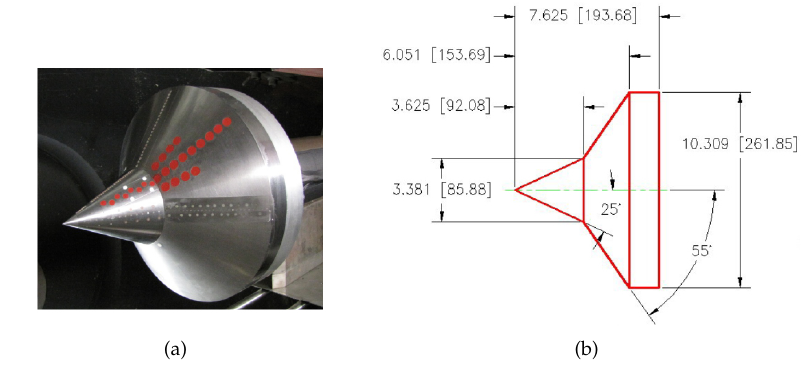
Figure 1. Double-cone configuration. ( a ) Double-cone model installed in the LENS XX tunnel; ( b ) Dimensions in inches